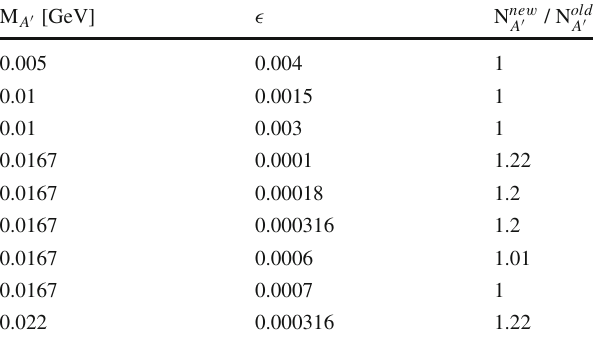
Fig. 4 X 17 simulated in the visible mode 2018 setup. Two different cuts are used to discriminate between two X 17 topologies. The first one is based on angle cut and vertex position using information from the 4 GEM stations installed in the decay volume and is very efficient on the X 17 produced at low energy (red triangle). The second one relies on the Veto placed at the end of the dump and is more efficient for the high energy population (blue square)